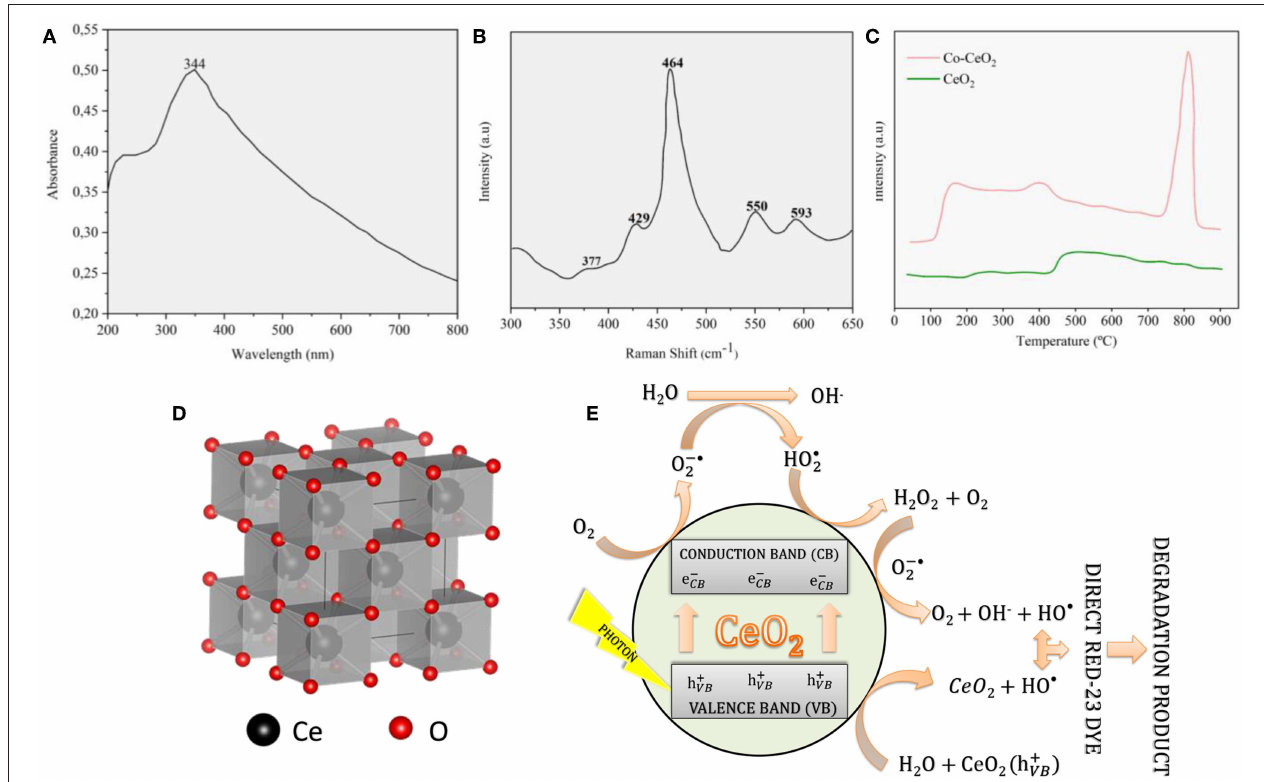
FIGURE 8 | (A) UV–Vis spectrum UV-Vis spectrum of CeO 2 nanoflakes, (B) Raman-scattering spectrum of prepared CeO 2 nanoflakes, (C) O 2 -TPD profiles of pure CeO 2 and Co-CeO 2 (D) CeO 2 unit cell and (E) Pictorial representation of degradation mechanism for the photocatalytic degradation of DR-23 under UV-light irradiation (adapted from Umar et al., 2015; Li et al., 2018).